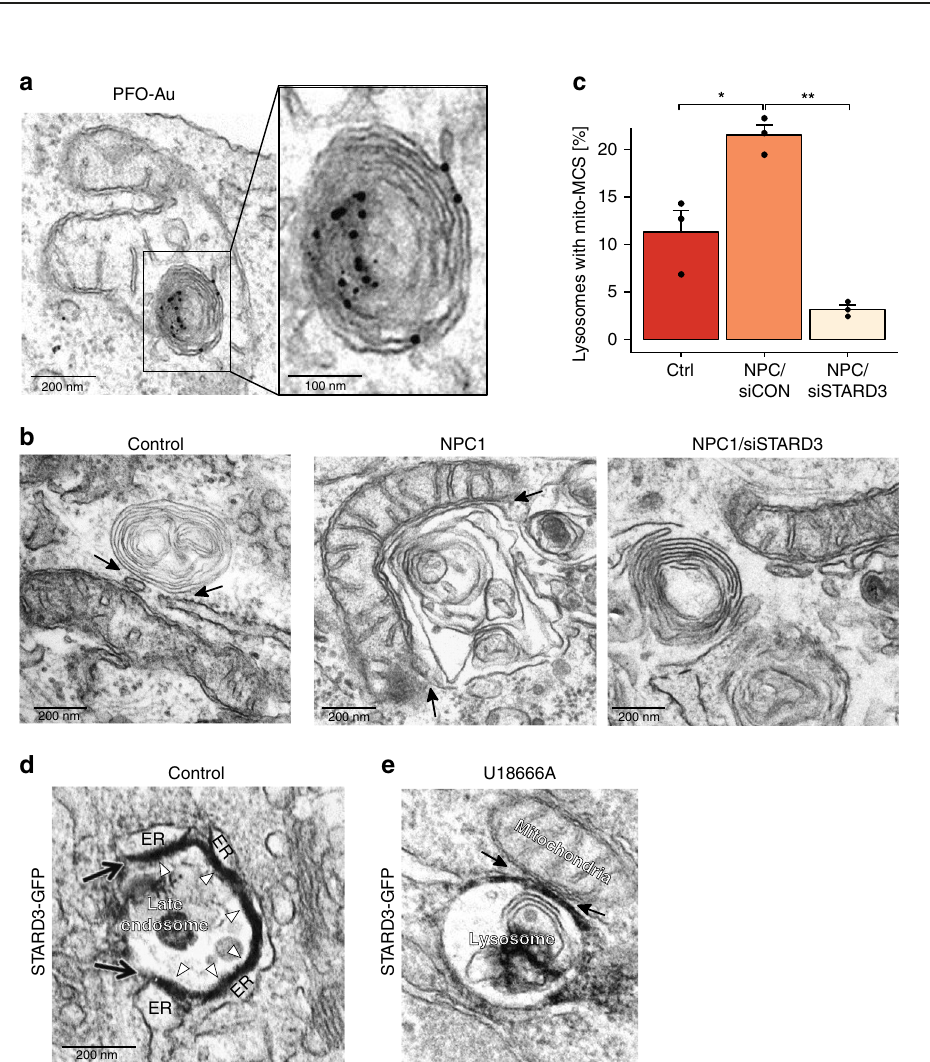
Fig. 5 Increased lysosome-mitochondria contact sites in NPC1-de fi cient cells. a Electron micrographs of HeLa cells treated with non-targeting control siRNA (siCON), NPC1-siRNA (siNPC1) or with Gramd1b-siRNA (siGramd1b) showing lysosome MCSs (black arrows) with ER in control or mitochondria in NPC1 or Gramd1b-depleted cells. Scale bar, 200 nm. b The percentage of endocytic organelles with a mitochondria MCS from a were quanti fi ed and expressed as the mean of three independent experiments + SEM. Welch two sample t-tests were performed between siCON and treatment conditions (siNPC1:** P = 0.00615, siGramd1b:** P = 0.00412). c Electron micrograph of HeLa cells pulsed with HRP for 2 h prior to treatment with U18666A (2 µ g/mL for 18 h). Asterisks indicate HRP-containing organelles, identi fi ed by the electron-dense reaction product. Scale bar, 450 nm and 200 nm in boxed enlargement d Representative electron micrographs of HeLa cells treated with U18666A (2 µ g/mL for 18 h) and stained for endogenous Tom20 using pre- embedding labelling. Tom20-stained OMM appears to surround the lysosome. Scale bar, 100 nm. e Slices from a tomographic reconstruction from HeLa cells treated with U18666A (2 µ g/mL for 18 h). Red lines, mitochondrial membrane. Scale bar, 200 nm